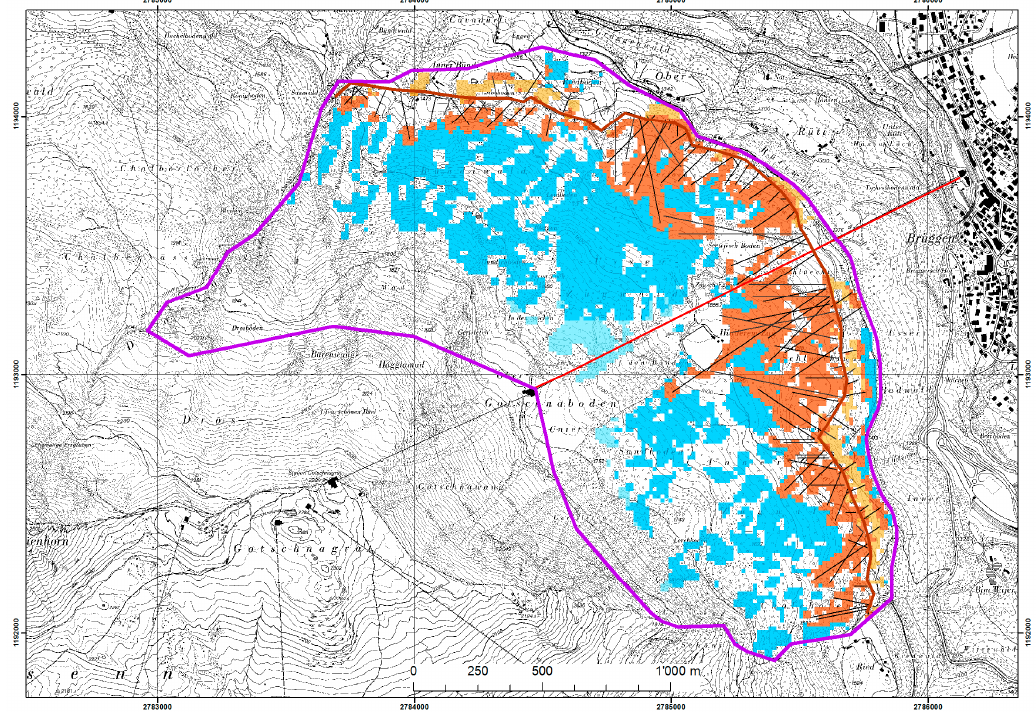
Figure 13. Harvesting and CR layout for MIN-UR (minimize length in unfavorable CR direction) (topographic map © swisstopo (JA100118)).